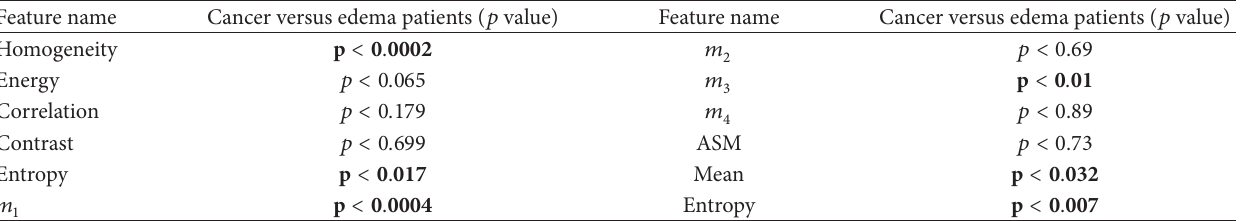
Table 4: ANOVA (1 between-subject factor) results summary of statistics 𝑝 value for patients Haralick texture features cancer versus edema